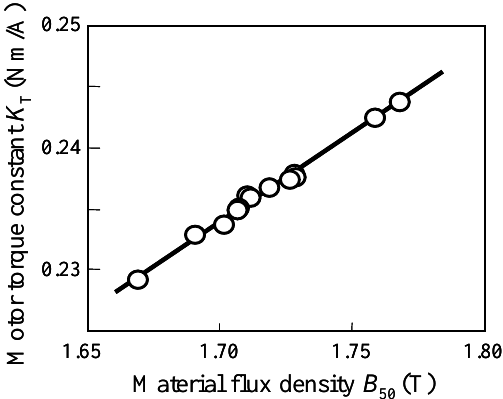
Figure 3. Relationship between motor torque constant and material flux density B 50 . Magnetic properties were measured by ring core samples.